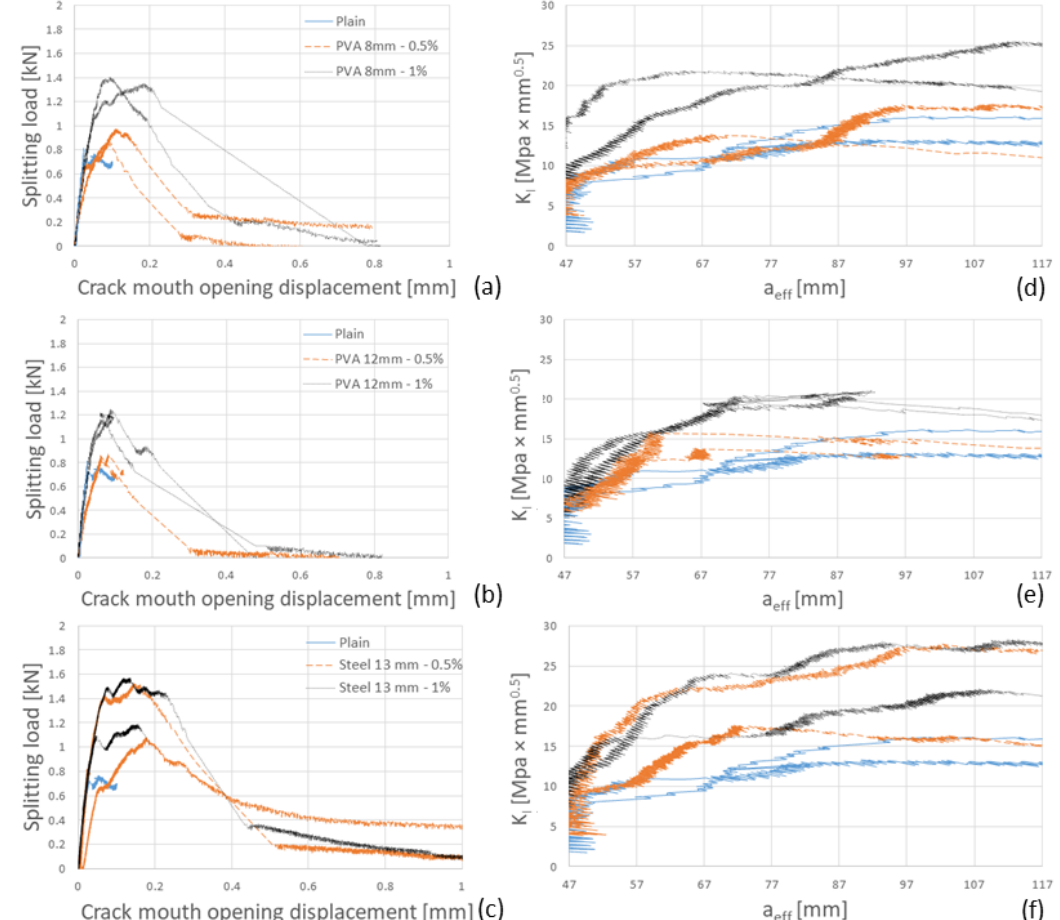
Figure A2. Splitting load (SL) versus crack mouth opening displacement (CMOD) curves of ( a ) 8 mm PVA interface; ( b ) 12 mm PVA interface; ( c ) 13 mm Steel interface, crack growth resistance curves (in terms of SIFs, KI, versus effective crack length, aeff) of ( d ) 8 mm PVA interface; ( e ) 12 mm PVA interface; ( f ) 13 mm steel interface.